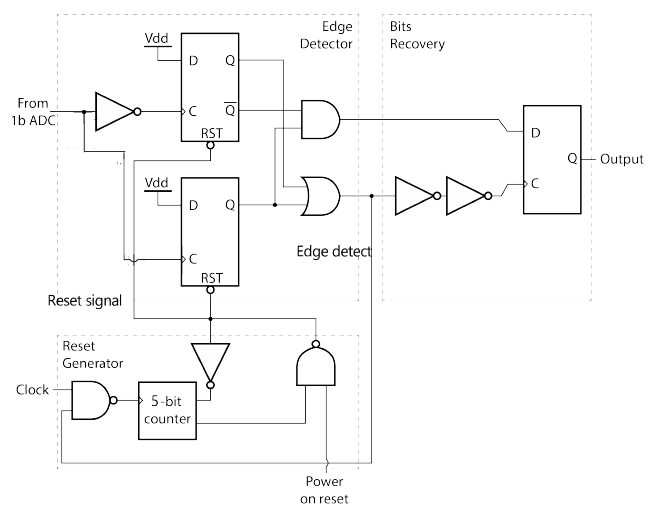
Figure 6. Schematic diagram of the 1-bit ADC.